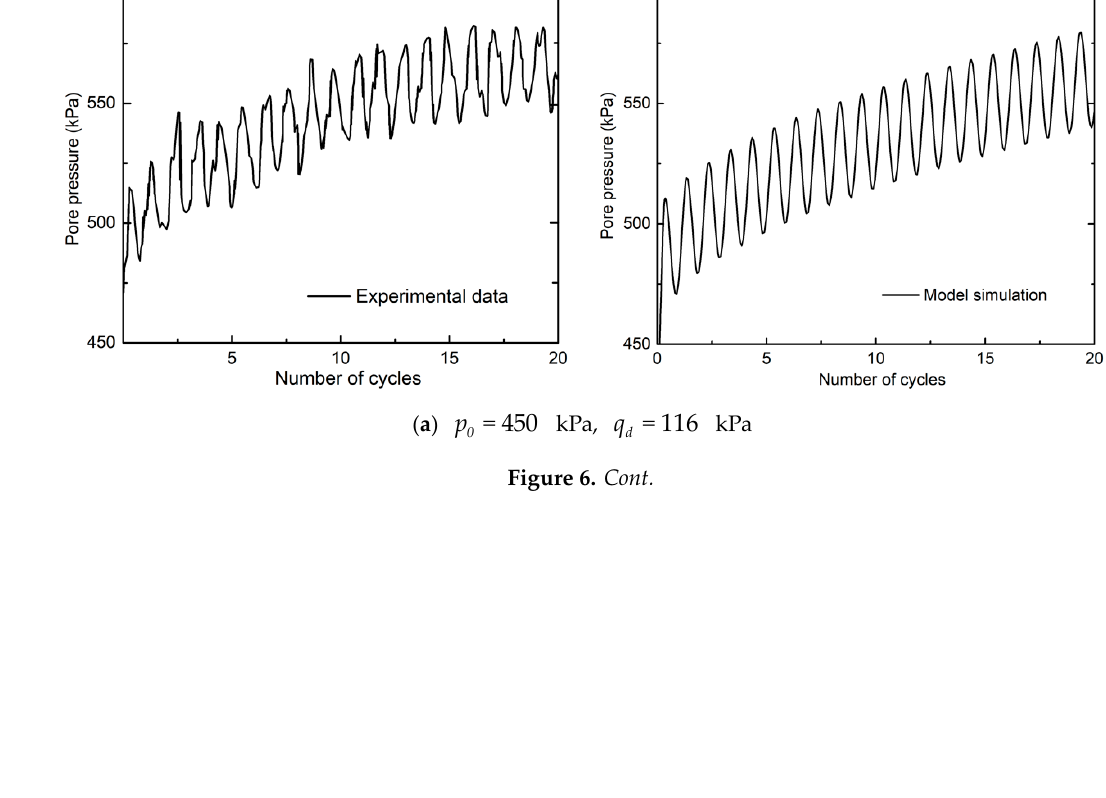
K = 0.8 . 0 K = 0.8 . Figure 5. A comparison between the model simulation and experimental data with K = 0.8. 0 0